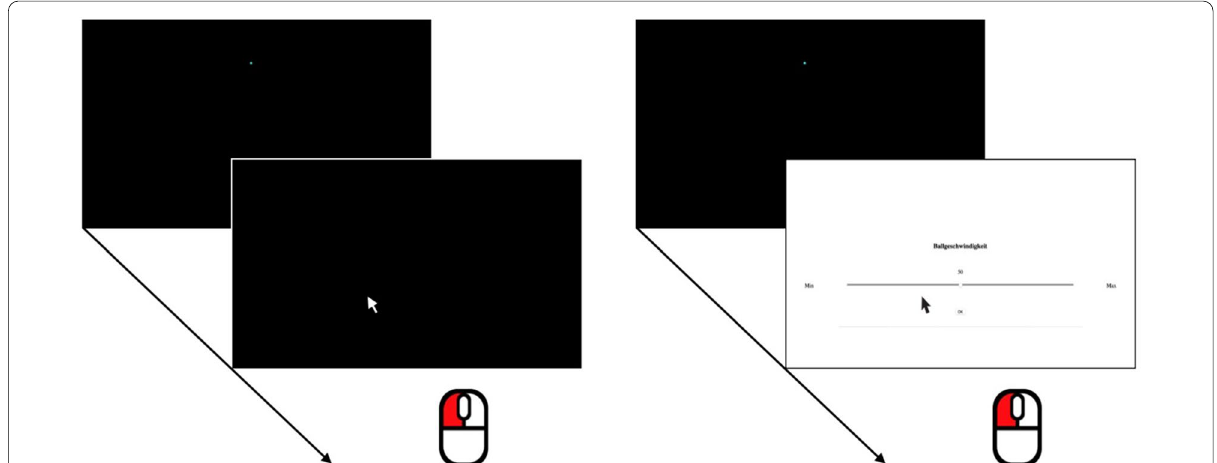
Fig. 3 Left panel: In the location anticipation block, participants indicated the position where they anticipated that the observed circle would next change its trajectory. Right panel: In the speed judgment block, participants rated the circle’s speed using an analogue slider (ranging from “min” to “max”) with the mouse